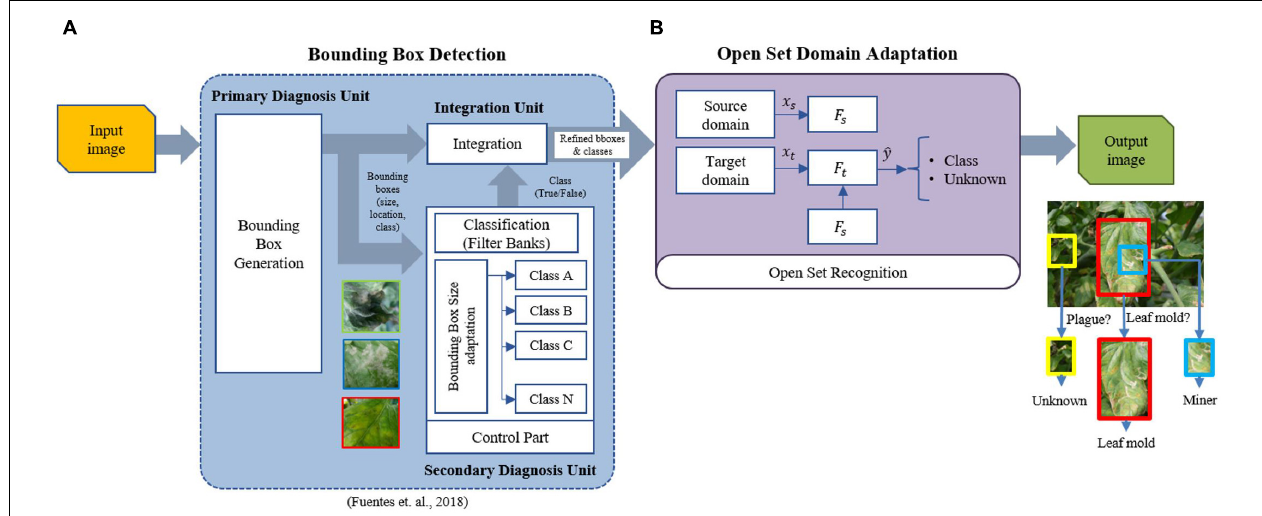
FIGURE 4 | Overall architecture of the proposed work. The system is composed of two blocks: bounding box detector and open set domain adaptation. (A) The bounding box detector generates the required bounding boxes using the refinement filter bank method (Fuentes et al., 2018). (B) Open set domain adaptation utilizes the set of regions generated by the detector to perform open set recognition by domain adaptation of the source domain (labeled known classes) to the target domain (unlabeled known classes + unknown class). Please see Figure 5 for a detailed description of the components in (B) .